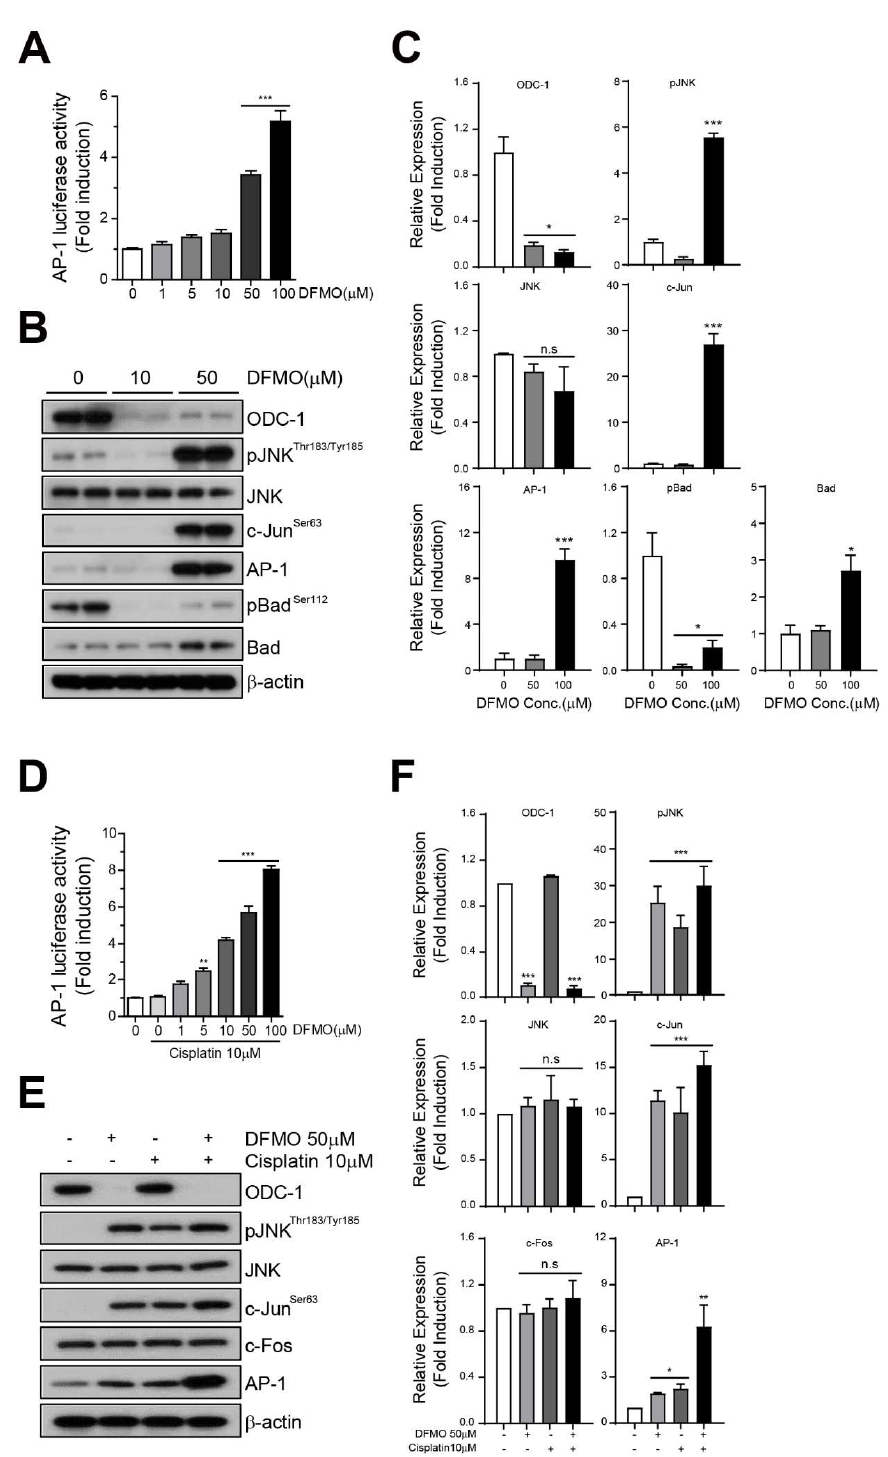
Figure 4. Induction of AP-1 activity and JNK signaling using the combination therapy of DFMO and cisplatin. An AP-1 luciferase plasmid vector was transiently transfected into SKOV-3 cells for 48